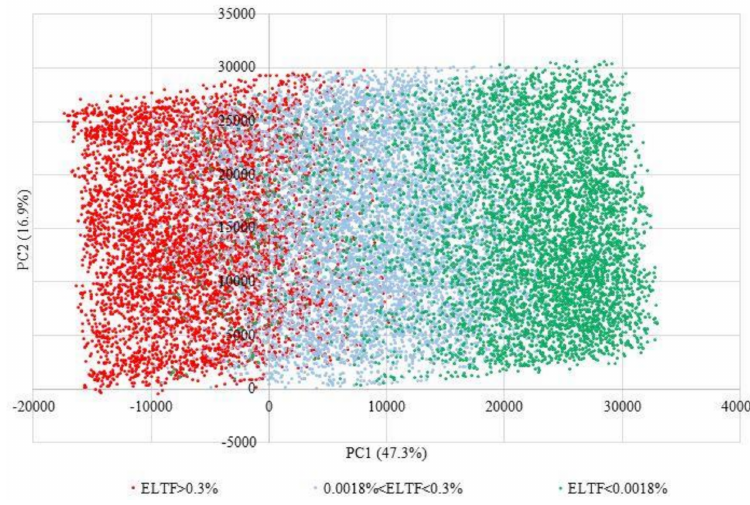
Figure 4. Bi-plot of ELTF values in the non-leaky ensemble.